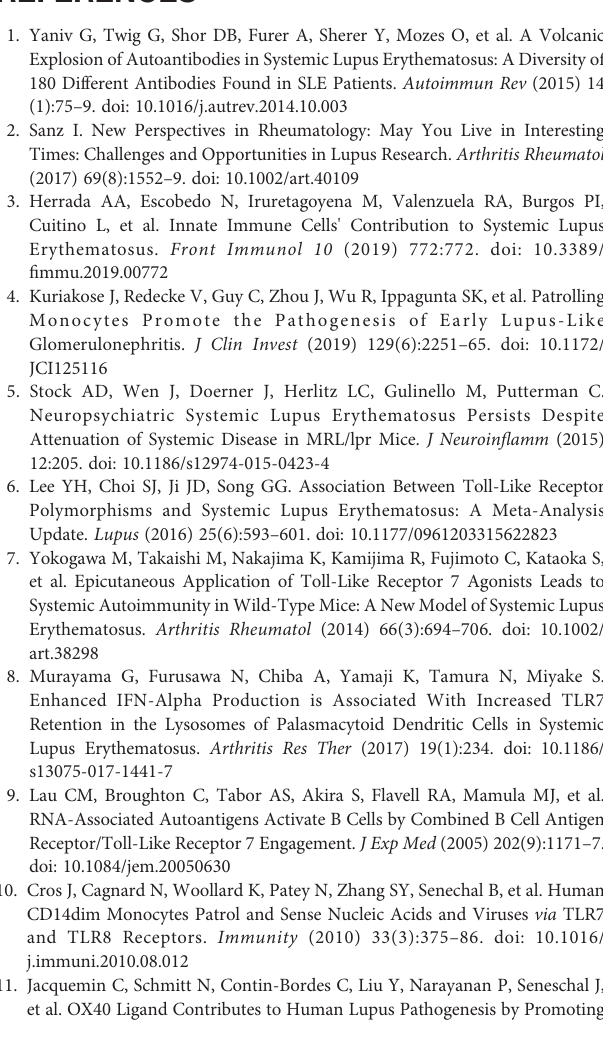
Supplementary Figure 2 | Proteinuria in IMQ-induced lupus mice and CD11b expression in kidney monocyte-like cells and macrophages. (A) Nephritis was induced by the long-term application of IMQ, which was con fi rmed by proteinuria in C57BL/6 mice (left) and NZB/NZW mice (right). C57BL/6 mice were treated with 40 mg topical IMQ three times a week for 5 weeks. NZB/NZW mice were treated with 10 mg topical IMQ three times for 3 weeks. Symbols represent individuals and horizontal lines indicate the mean and SEM. *P < 0.05 by Student ’ s t -test. (B) Flow cytometry analysisofCD11bexpression inLy6C lo monocyte-like cellsandMFinthe kidneys of control and IMQ-induced lupus mice. Representative histogram of fl uorescence intensity in each subset is shown.